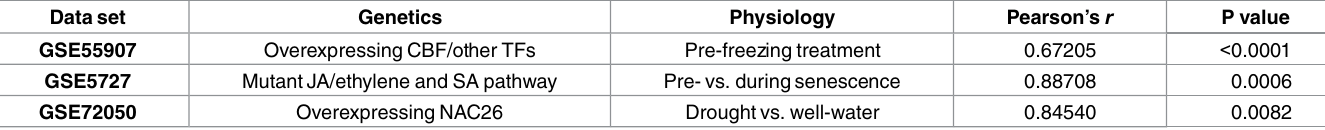
Table 2. Correlationanalysis of ATAF1 vs. PAO expression. Using Pearson correlation analysis it was found that ATAF1 correlatespositively and signifi- cantly with PAO at the P < 0.05 level in all threemicroarray datasets. Informationabout the geneticsand physiology of the data sets were also provided. Data